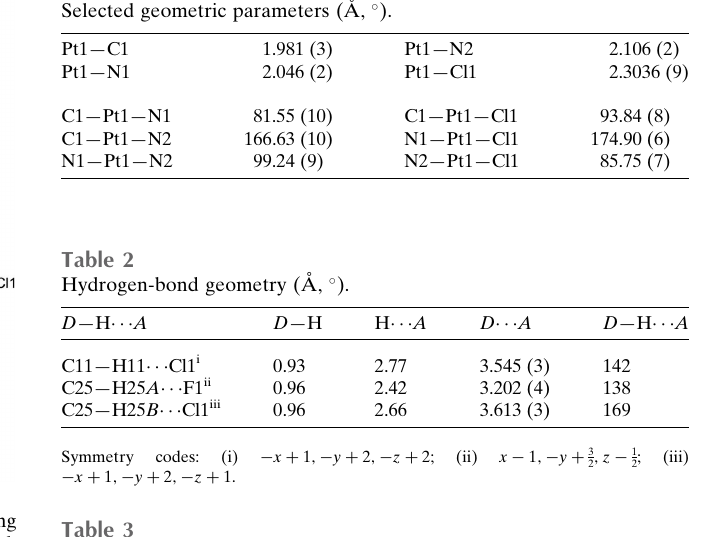
Table 3 Experimental